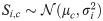
Surface interpolation of the expected changes in the AUC (in percentage) over the AUC of the best member of the group, for different group sizes, according to the theoretical model, when the distributions of scores for both classes are given by normally distributed random variables, Si,c∼N(μc,σi2), with |μC1 = L − μC2 = R| = 1 and standard deviations σi ∈ [0.3, 4].(A) Size 2. (B) Size 4. (C) Size 6. (D) Size 8.